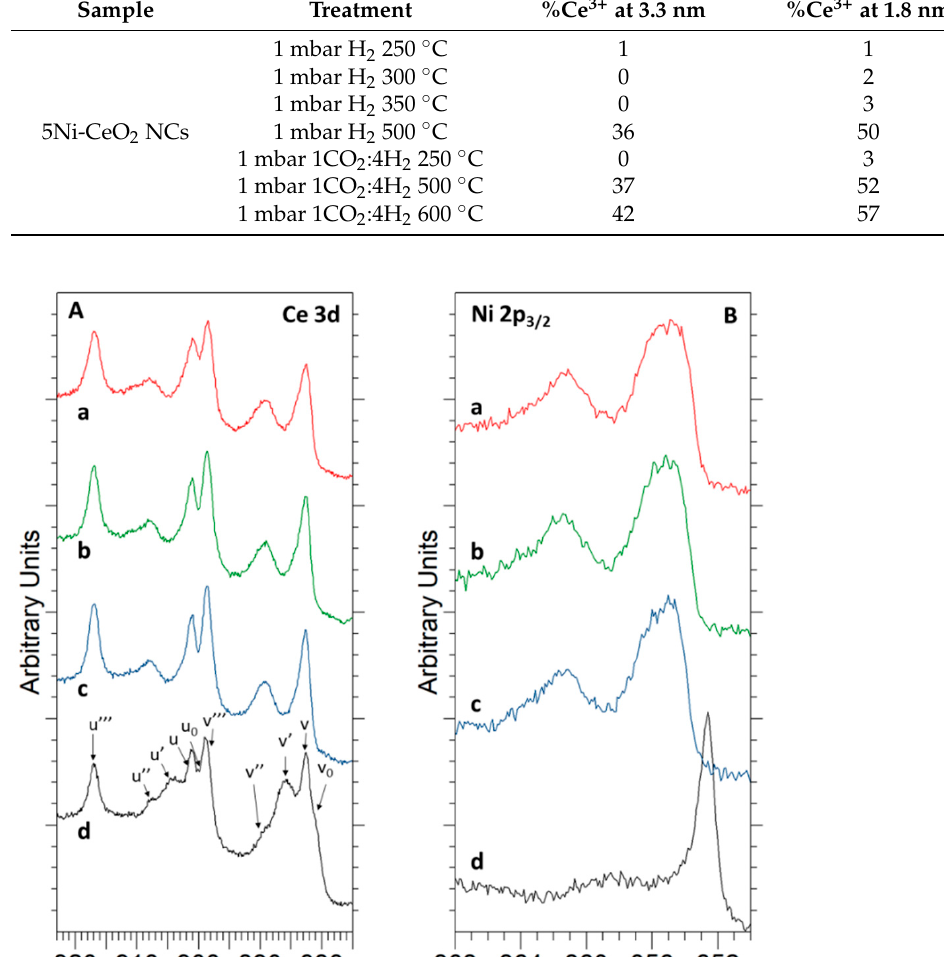
Table 2. Cont. Sample Treatment %Ce 3+ at 3.3 nm %Ce 3+ at 1.8 nm